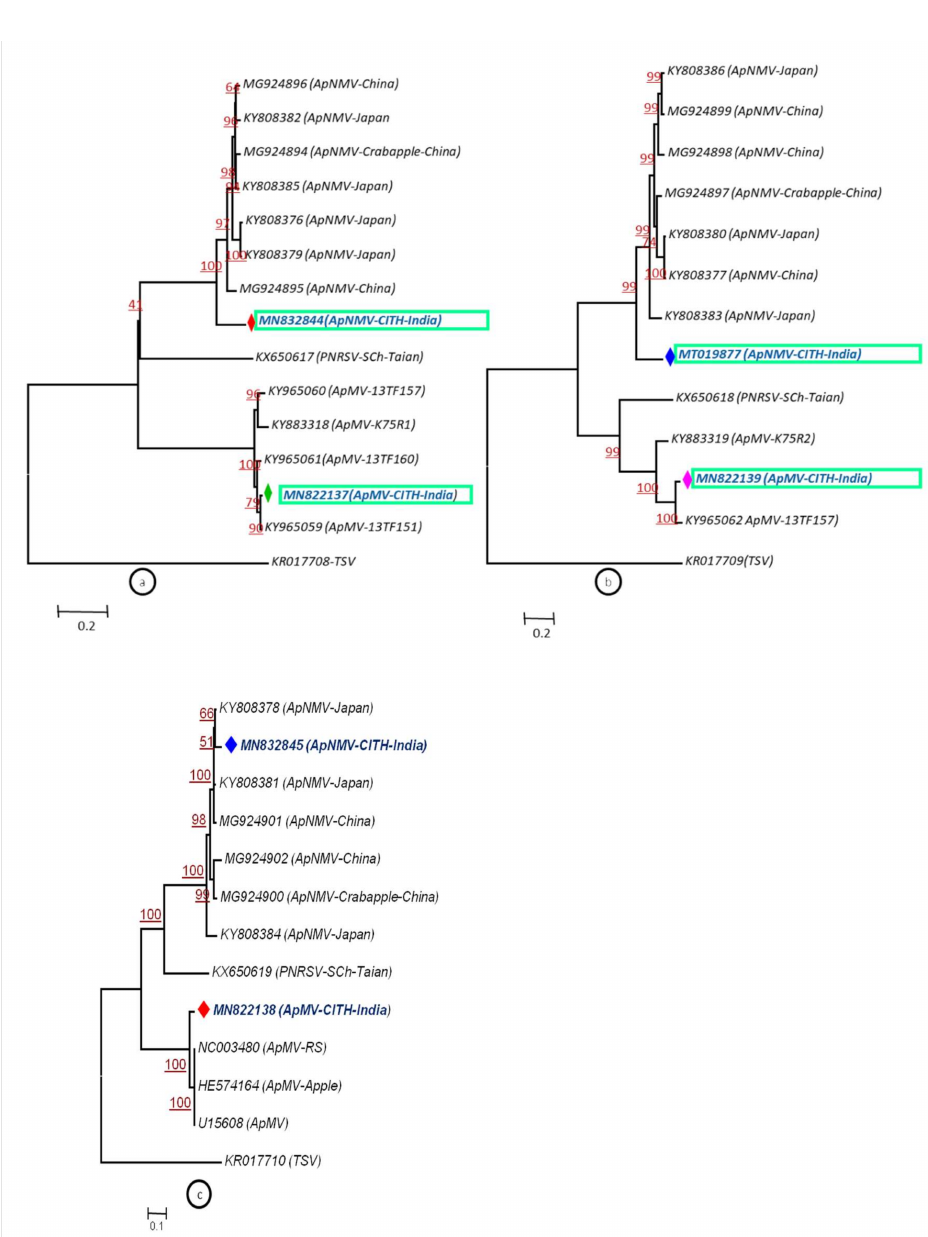
Figure 5. ( a – c ) Phylogenetic relationship of apple mosaic virus and apple necrotic mosaic virus using RNA 1 ( a ), RNA 2 ( b ) and RNA 3 ( c ) nucleotide sequence alignment through NJM at 1000 replications for each bootstrap value using MEGA 7.0; our ApNMV from cv.OS and ApMV from cv.GD isolates are highlighted with different colors in phylogeny. TSV (Tobacco streak virus) represents out-group in the same